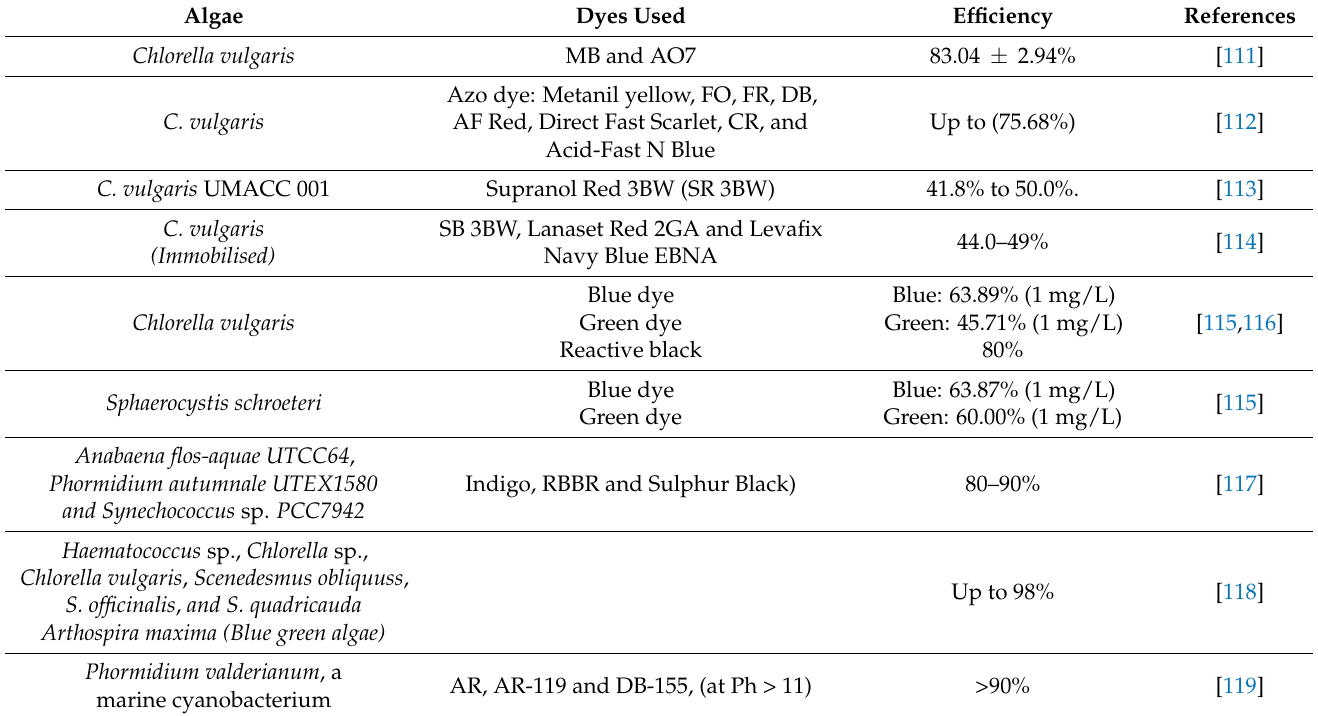
Table 4. Algae-mediated decolourization of textile